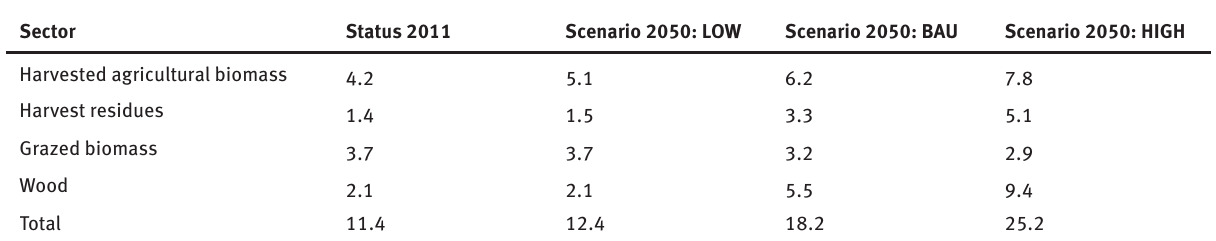
Table 1: Biomass supply of the world 2011 and 2050 in different scenarios, in bil lion tonnes dry matter (based on Piotrowski et al. 2015)